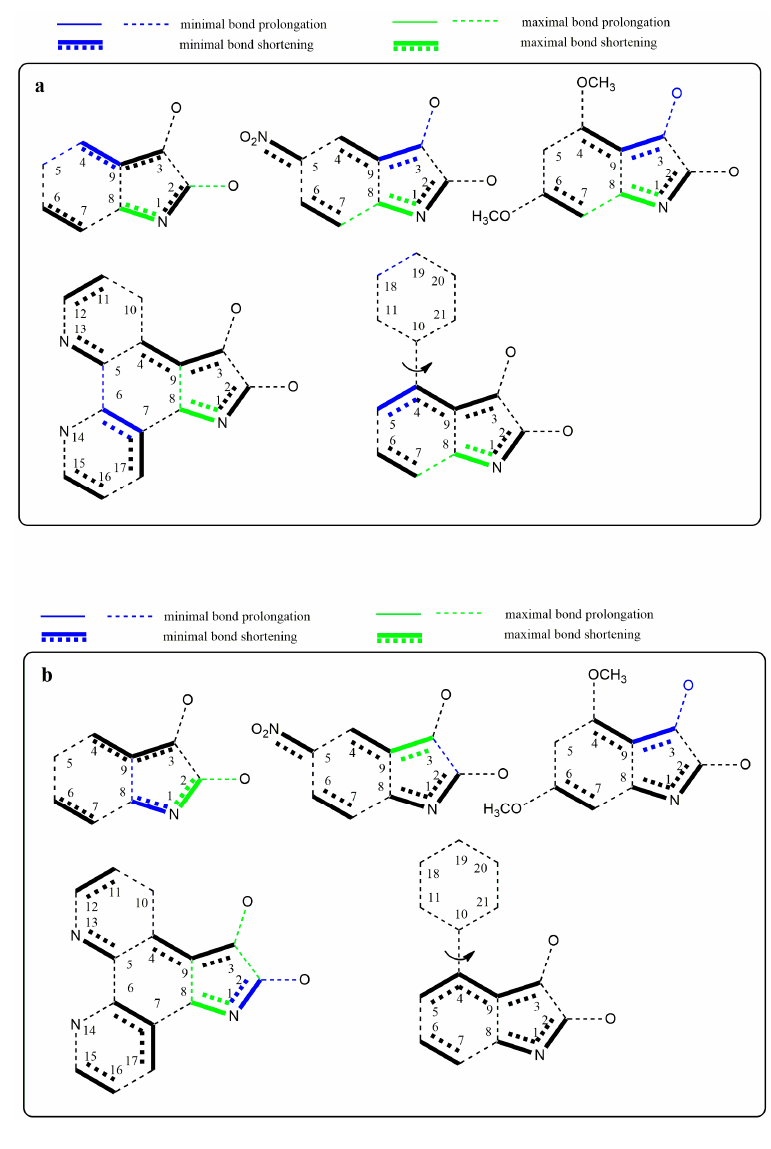
Figure 10. Graphical representation of the bond length differences. ( a ) Comparison of the isatin derivatives and their respective azanions; ( b ) depiction of the most and least distinct bond length changes caused by deprotonation of the isatine derivatives A – E .